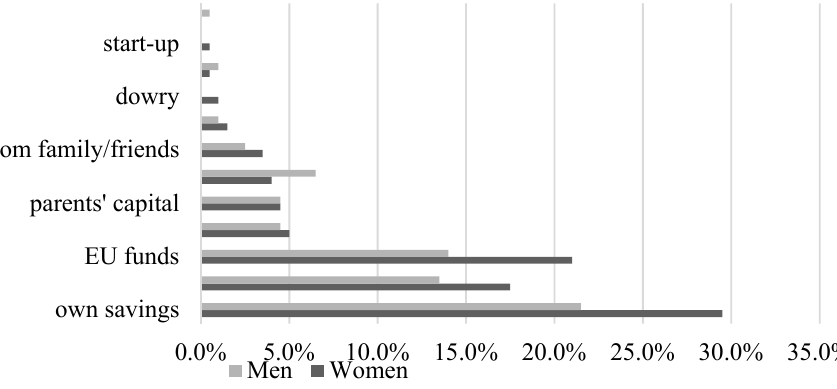
Figure 4. Structure of the sources of financing of enterprises set up by women and men [%]. Source: Own research